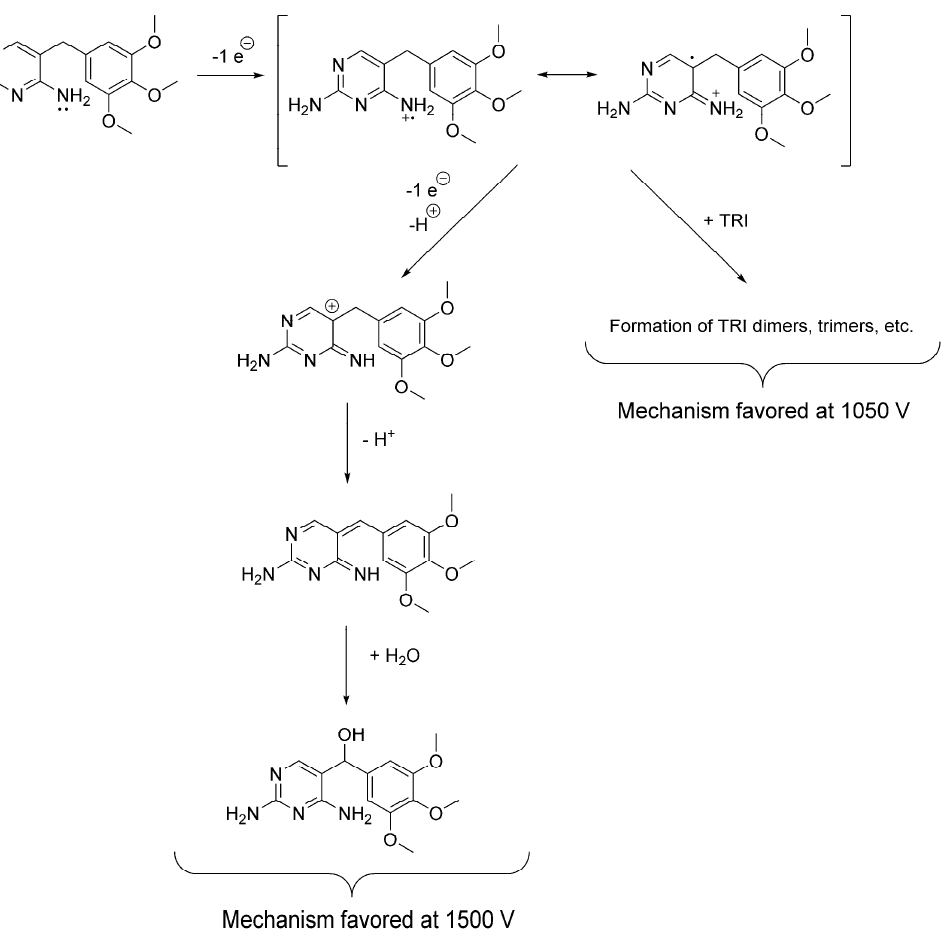
Figure 3. Proposed mechanism of formation of α -OH-TRI by electrolysis at 1500 V. The formation of the unidentified precipitated at 1050 V could be explained by the reaction of a radical intermediate with TRI.